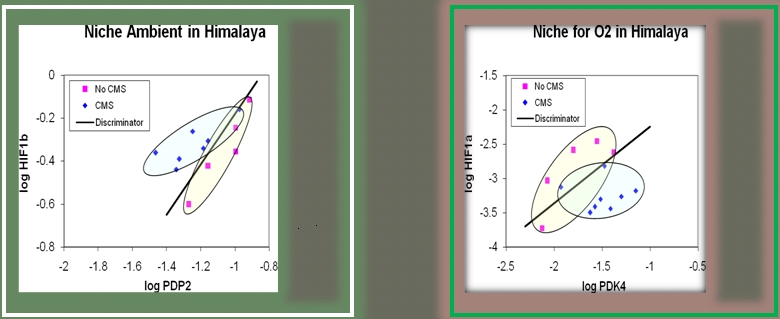
Niche (scatter) plots of genes that best predict the presence of CMS in Himalayan altitude dwellers.A. CMS vs Controls in Himalayans (Ladakh) at native altitude and ambient conditions at 4450 m. and at the same altitude after 1 hour of hyperoxia (B). A. In Korzok village, Ladakh, the CMS patients and controls were clearly separated by the “discriminator line”. B. When ambient hypoxia was shown to have been replaced by induced normoxia, the CMS patients were still separated from control altitude dwellers, although the best predictors for CMS had changed. Discriminator line based on discrimination of the two groups by logistic regression. CMS = chronic mountain sickness. PDK4 = . Pyruvate dehydrogenase Kinase 4. This kinase is involved in “aerobic glycolysis” (the Warburg effect).It supports a metabolic pattern seen in many (but not all) hypoxia adapted tissue, also in cancer cells and activated immune cells. PDP2 = phosphatase that de-phosphorylates the E1-alpha subunit of pyruvate dehydrogenase. HIF1a, HIF2a, HIF3a, HIF1b = Hypoxia Inducible Factors, composed of alpha and beta subunits. Only the alpha subunit protein levels are regulated by oxygen. HIF1b is used as a dimerizing partner by all three HIF1a's.